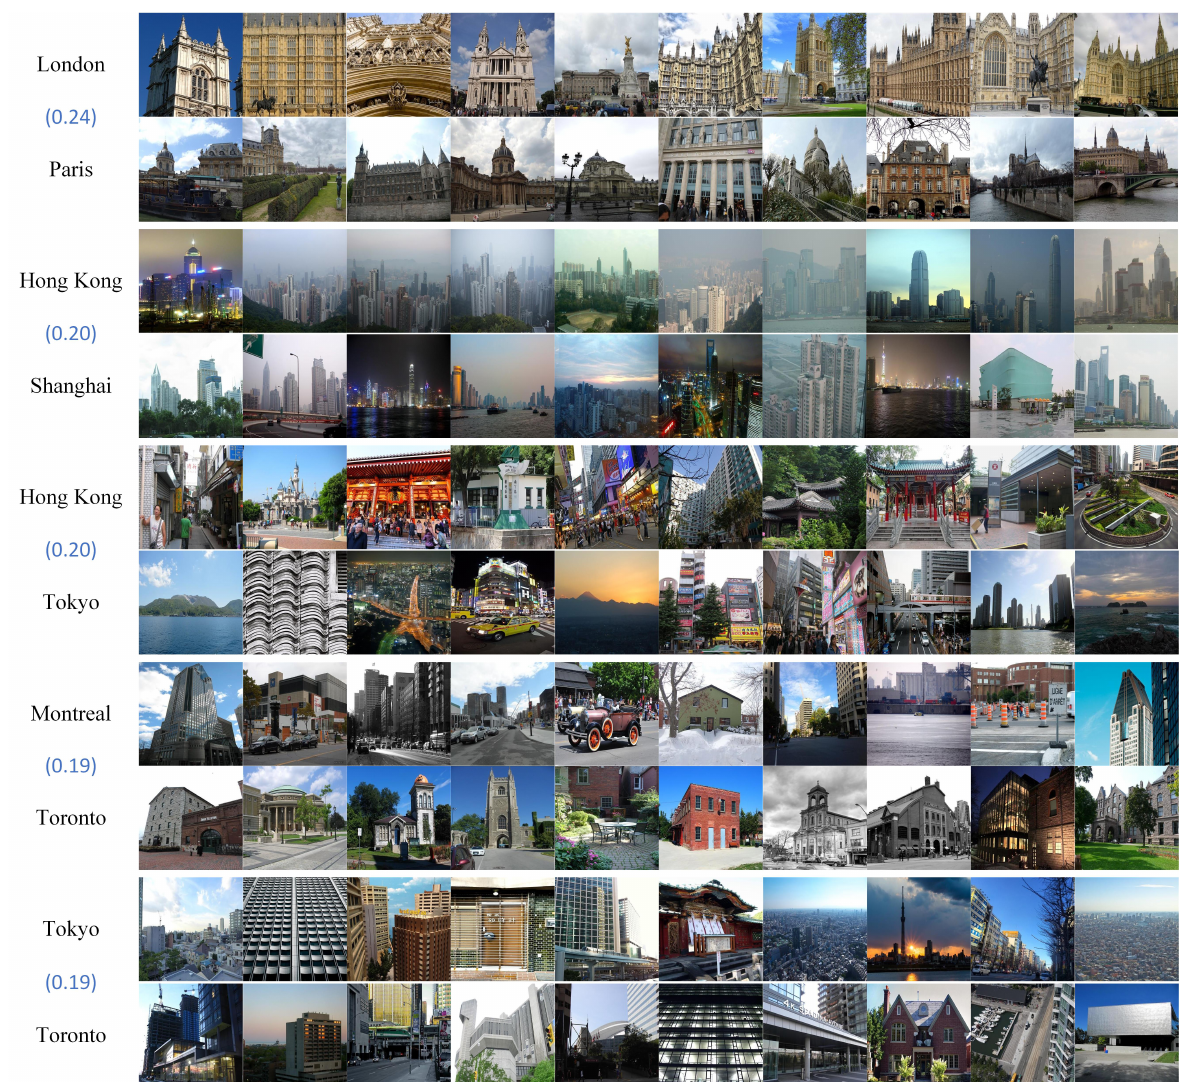
Figure 6. Top five pairs of city samples with the greatest landscape distance.